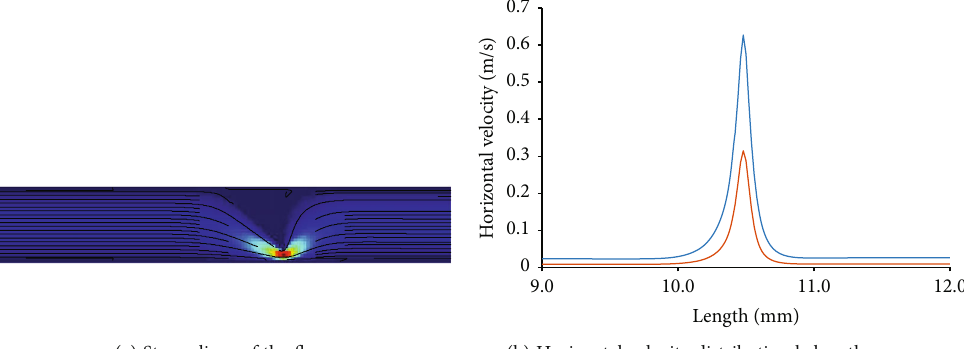
Figure 7: Simulation result of the fi rst situation.